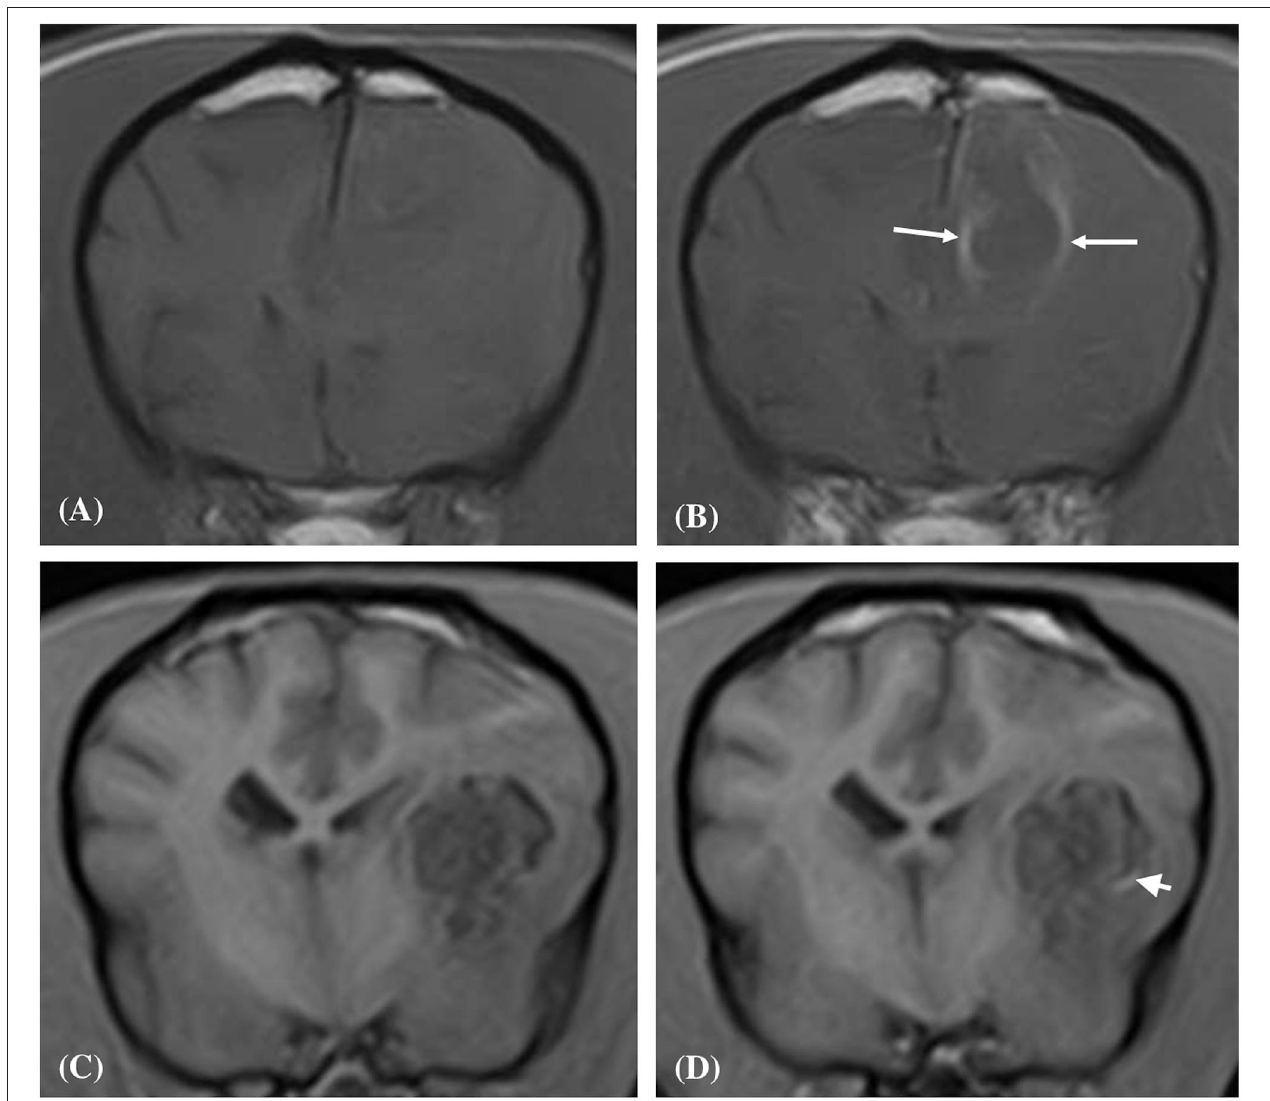
FIGURE 4 | Transverse plane T1-weighted (A) , and T1-weighted post contrast (B) , images of a dog (Case 4) with an intracranial intra-axial hematoma affecting the white matter of the left fronto-parietal lobe. The lesion displays an obvious peripheral contrast enhancement pattern (long white arrows) (B) . Transverse plane T1-weighted (C) , and T1-weighted post contrast (D) images of dog (Case 1) with a hematoma lesion affecting the white matter of the medial aspect of the left temporo-frontal lobe and internal capsule. The lesion displays a faint and focal area of peripheral contrast enhancement (short white arrow). Neither lesions post contrast (B,D) show enhancement of their central